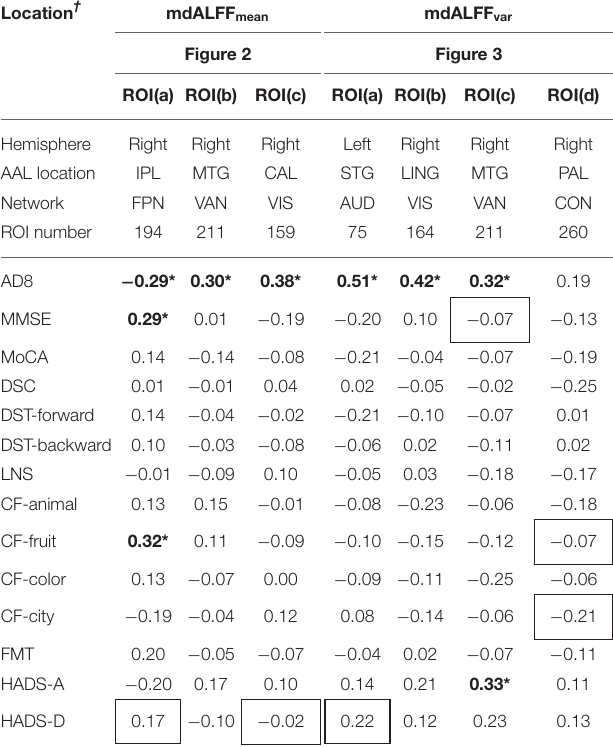
TABLE 2 | Partial correlation coefficient ( r ) of mdALFF mean and mdALFF var to clinical indices. Location †